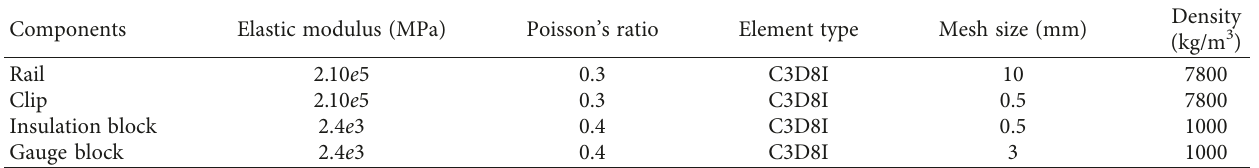
Table 1: Material parameter set.